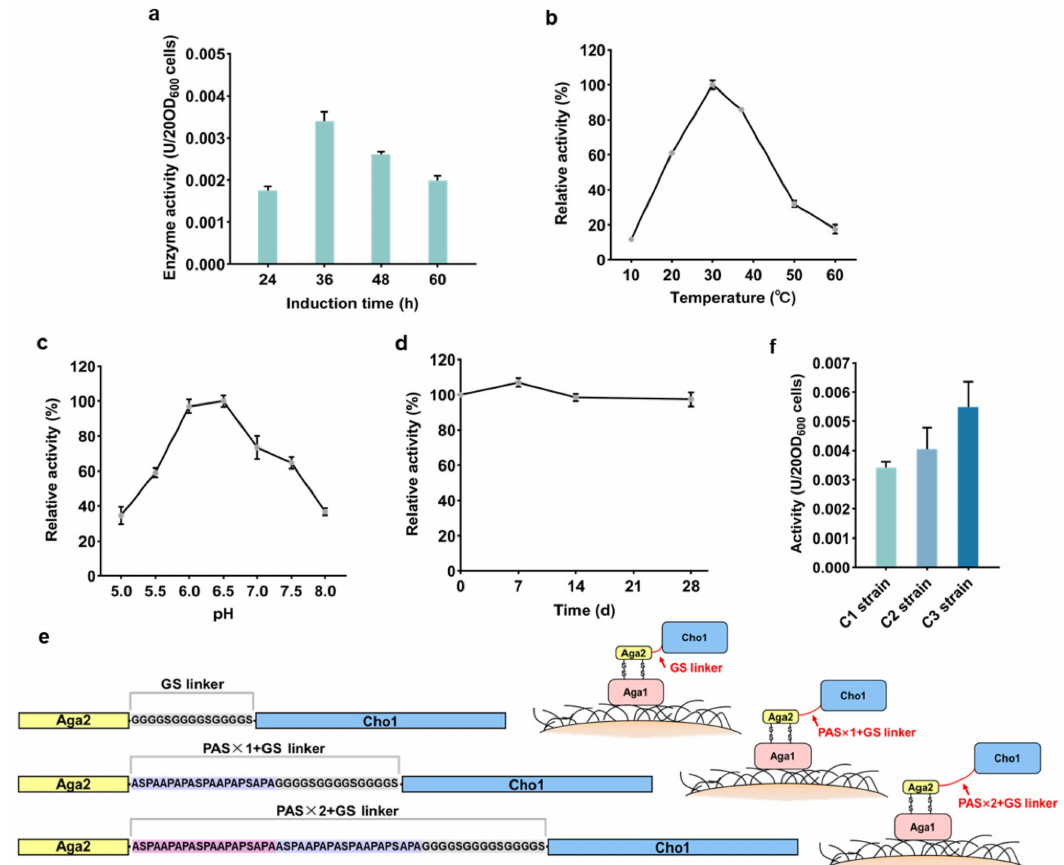
Figure 4. Determination of the catalytic activity of surface-displayed Cho1. ( a ) Activity of the displayed Cho1 at different time points after galactose induction. ( b – d ) Effect of ( b ) temperature, ( c ) pH and ( d ) storage time on the activity of Cho1. ( e ) Schematic representation of the linkers connecting Aga2 and Cho1. The original GS linker (GGGGSGGGGSGGGGS) was lengthened with one or two PAS sequences (ASPAAPAPASPAAPAPSAPA) to form the PAS × 1 + GS and PAS × 2 + GS linkers, respectively. ( f ) Activity of Cho1 with different linkers. Error bars indicate the SD of samples tested in